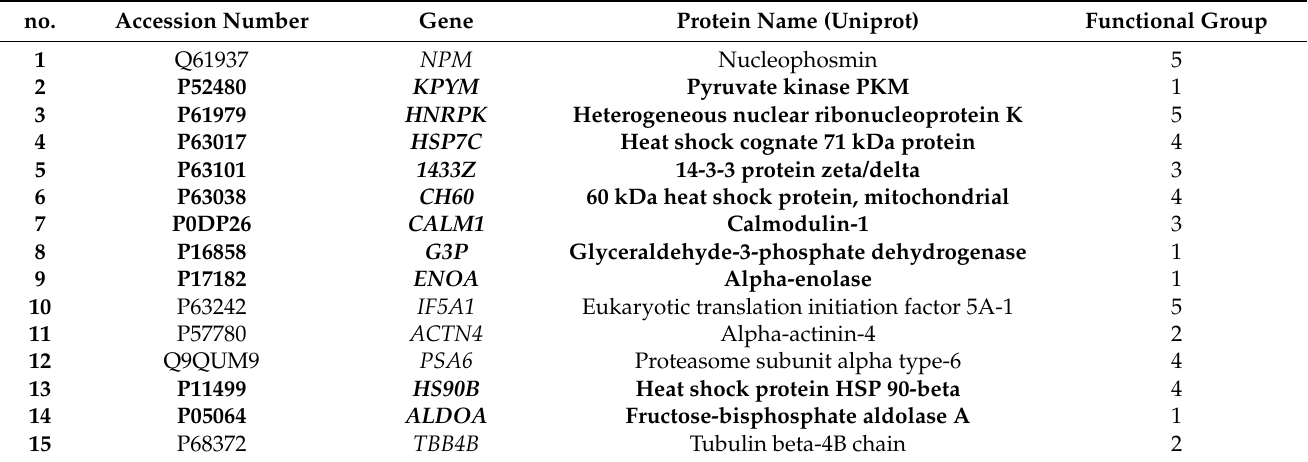
Table 3. Common mouse brain proteins interacting with the full-length PKM1 and the synthetic PK peptide *.